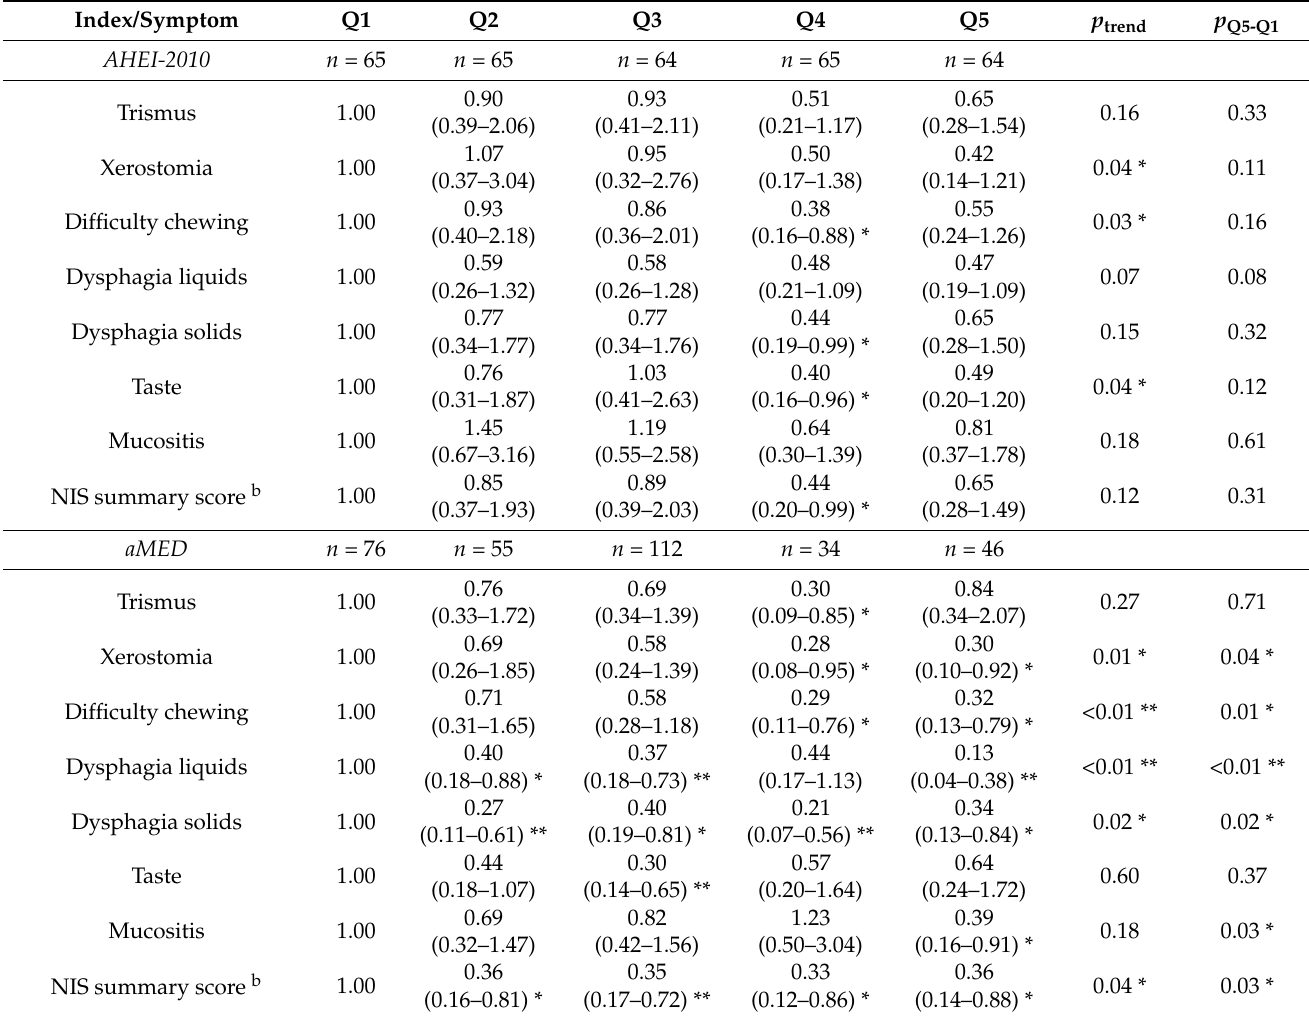
Table 4. Multivariable a ORs and 95% CI for association between quintiles of select diet quality index scores with being slightly to extremely bothered by at 1-year postdiagnosis (adjusted for baseline symptom levels) ( n =